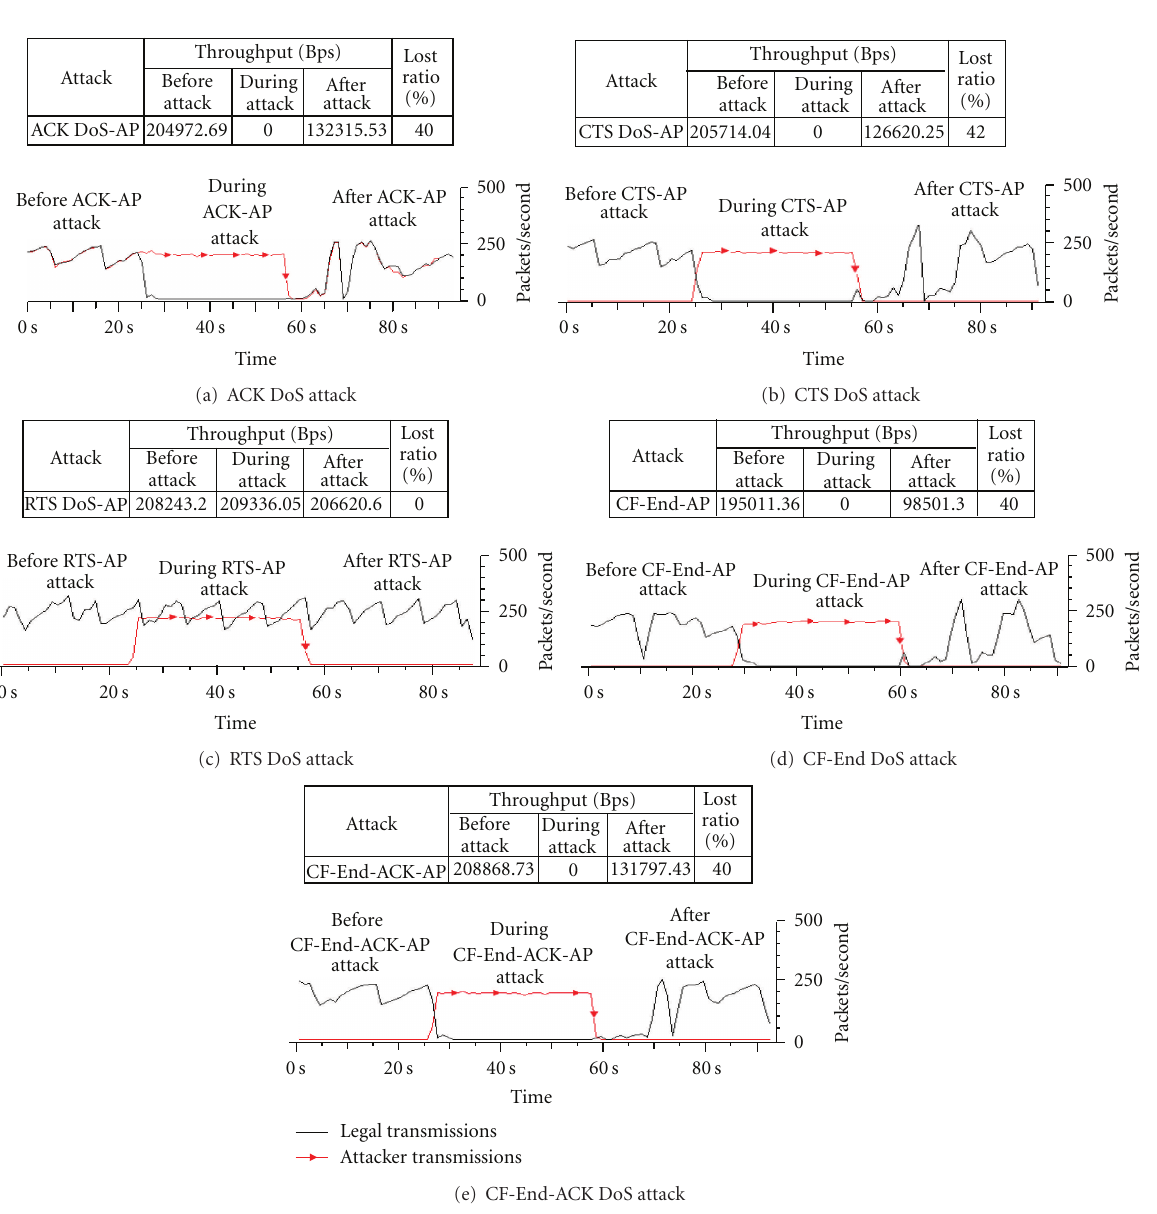
Figure 17: Impact of DoS attacks on performance of the wireless